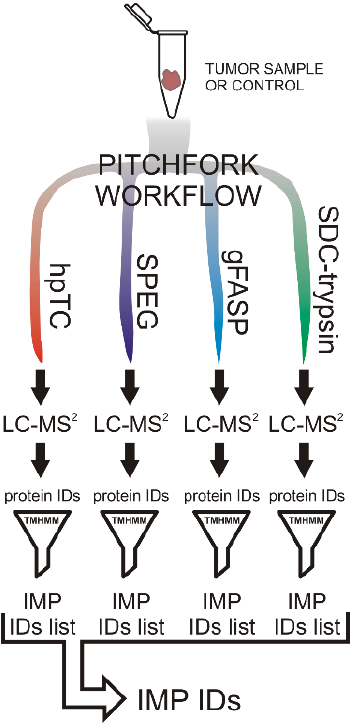
Figure 1. The PPGL membrane proteome analysis. Each sample was analyzed by the four methods comprising the Pitchfork strategy. Transmembrane segments of IMPs were isolated and analyzed using the hPTC method; glycosylated peptides were enriched by lectin affinity (N-glyco-FASP) and hydrazide chemistry (SPEG). Standard detergent (SDC) trypsin analysis captured non-glycosylated extra-membrane peptides. The four peptide samples were each analyzed by separate LC-MS/MS. TMHMM is a membrane protein topology prediction method based on a hidden Markov model.